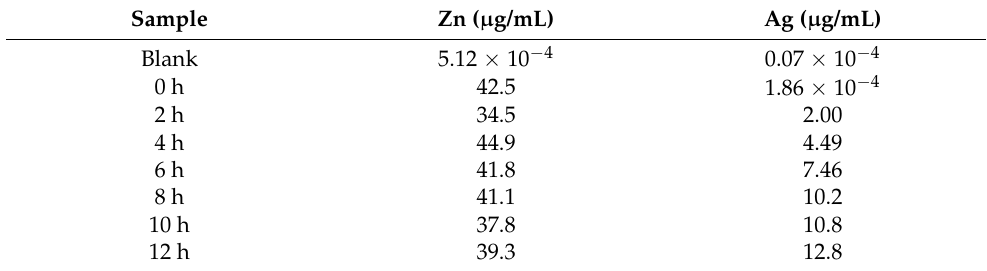
Table 2. ICP-MS of substrates with different silver-nanoparticle deposition times.